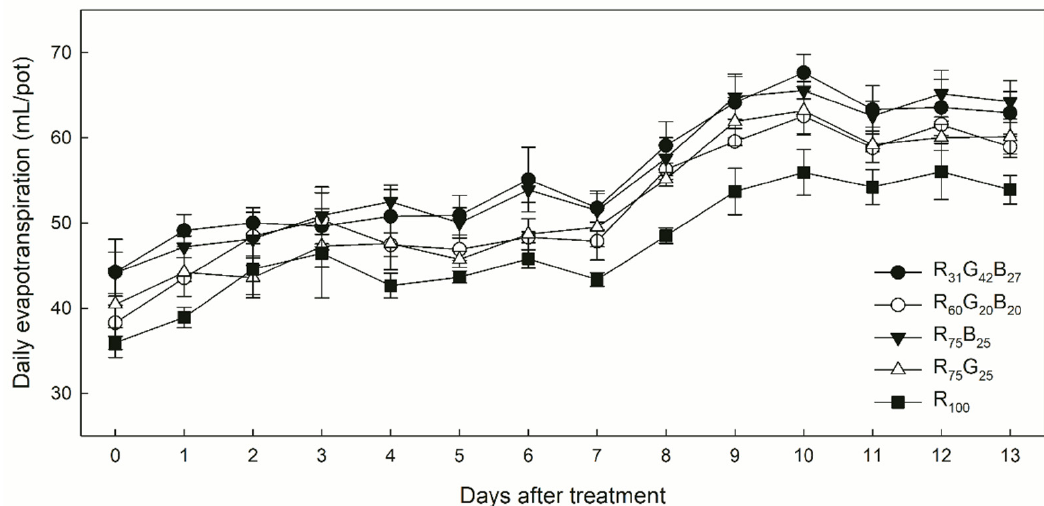
Figure 5. Daily evapotranspiration amount of Ocimum basilicum grown under five different combinations of red, green, and blue LEDs with the same light intensity for 14 days. The numbers after each waveband indicate the ratios of the intensities. The R 31 G 42 B 27 treatment mimics the sunlight spectrum measured in the experimental greenhouse. Pot weights were measured using load cells, and the decrease in weight recorded every 30 min was used to calculate the amount of evapotranspiration. Error bars indicate the standard error ( n = 3).